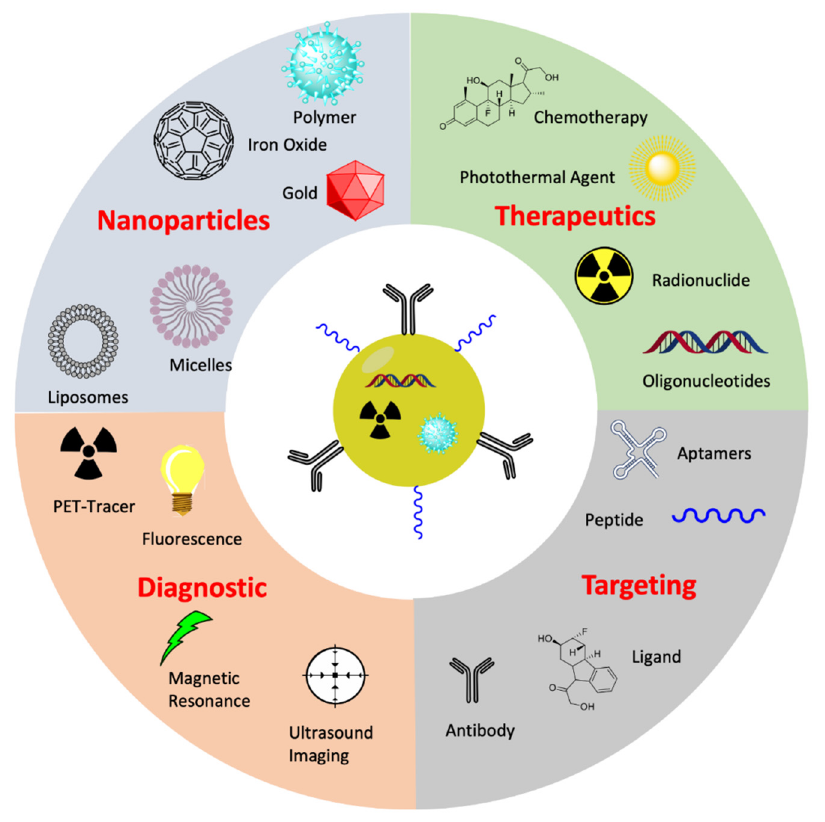
Figure 10. Schematic drawing of nanoparticles used for multimodal imaging and therapy (created with Biorender).